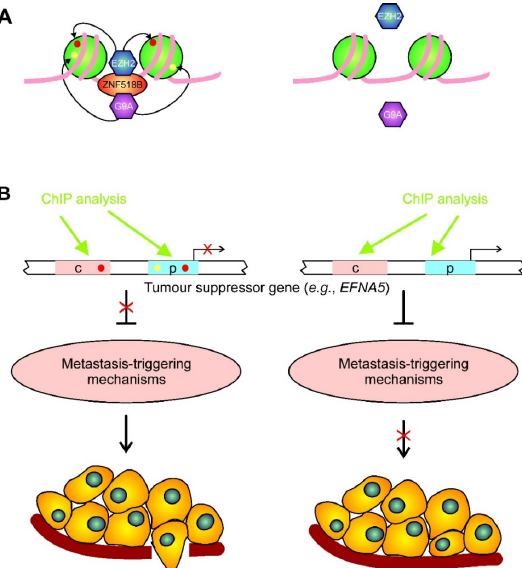
Figure 6. A possible mechanism for ZNF518B oncogenic role. ( A ) Schematic drawing of the starting hypothesis for the chroma- tin immunoprecipitation (ChIP) experiments. ZNF518B binds a specific DNA target in a tumour suppressor gene and recruits a histone methyltransferase (EZH2 or G9A), which catalyses the introduction of the repressive marks (H3K27me3, red ovals, or H3K9me3, yellow ovals, respectively) in the histones of the neighbouring nucleosomes (left). In the absence of ZNF518B, the histone methyltransferases are no longer recruited, and the repressive marks are not introduced (right). ( B ) The presence or absence of the methyltransferases and/or of the repressive epigenetic marks, either in the promoter (p) or in some control re- gion (c), determines the expression of a suppressor gene. These epigenetic features can be experimentally detected by ChIP analysis. The expression of the suppressor gene, in turn, controls the triggering of mechanisms that eventually result in the dissemination and metastasis of tumour cells as a consequence of ZNF518B